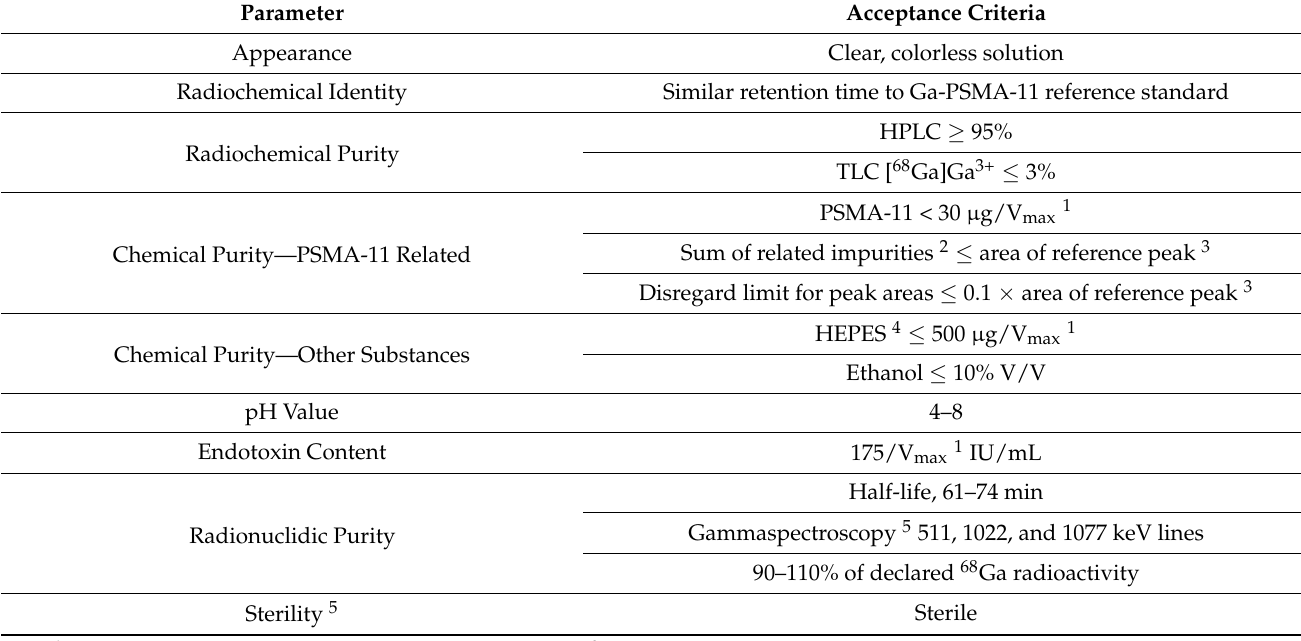
Table 1. Acceptance criteria for [ 68 Ga]Ga-PSMA-11 injection solution based on the European Pharmacopoeia monograph [47].